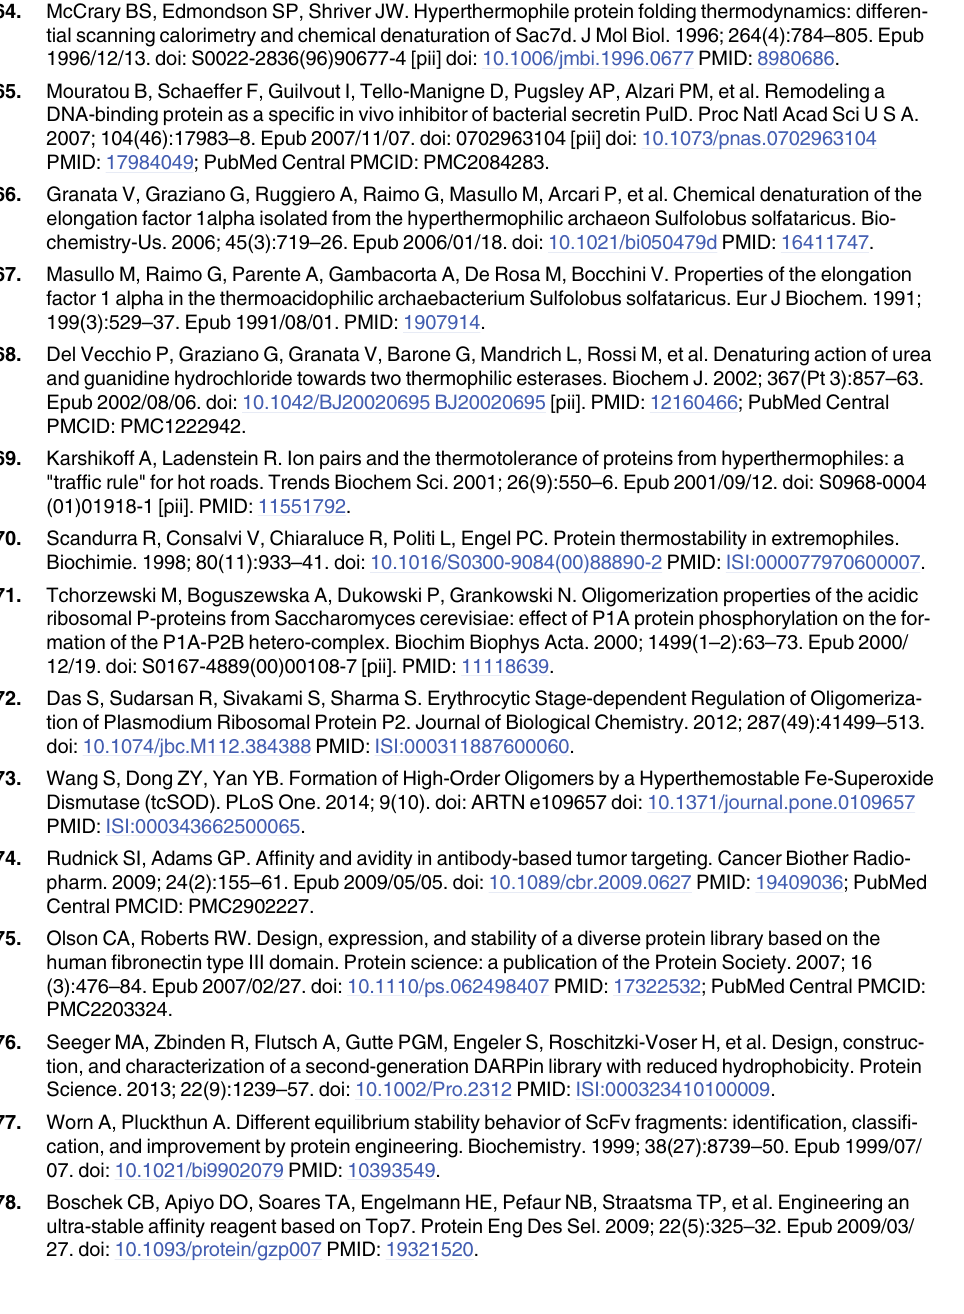
PLOS ONE | DOI:10.1371/journal.pone.0134906 August 6,